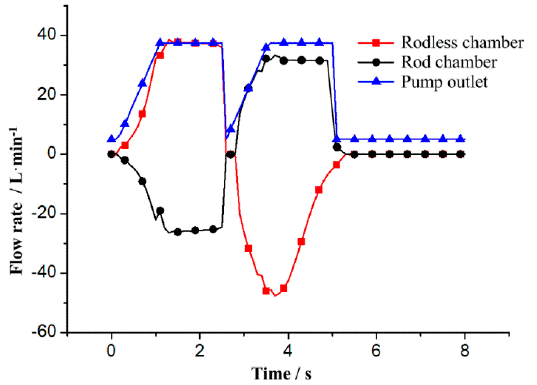
Figure 7. Flow rate curves of the pump outlet and the two chambers of the arm cylinder.